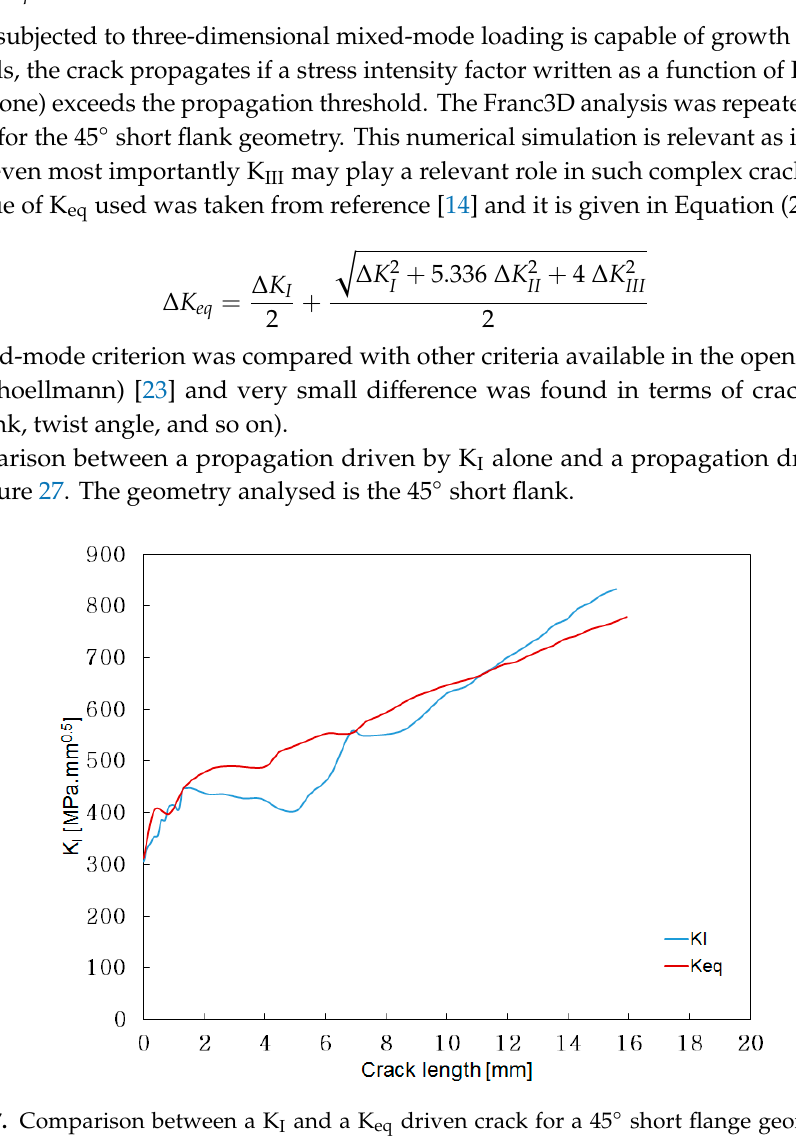
Figure 27. Comparison between a K I and a K eq driven crack for a 45° short flange geometry, 95% crack front.